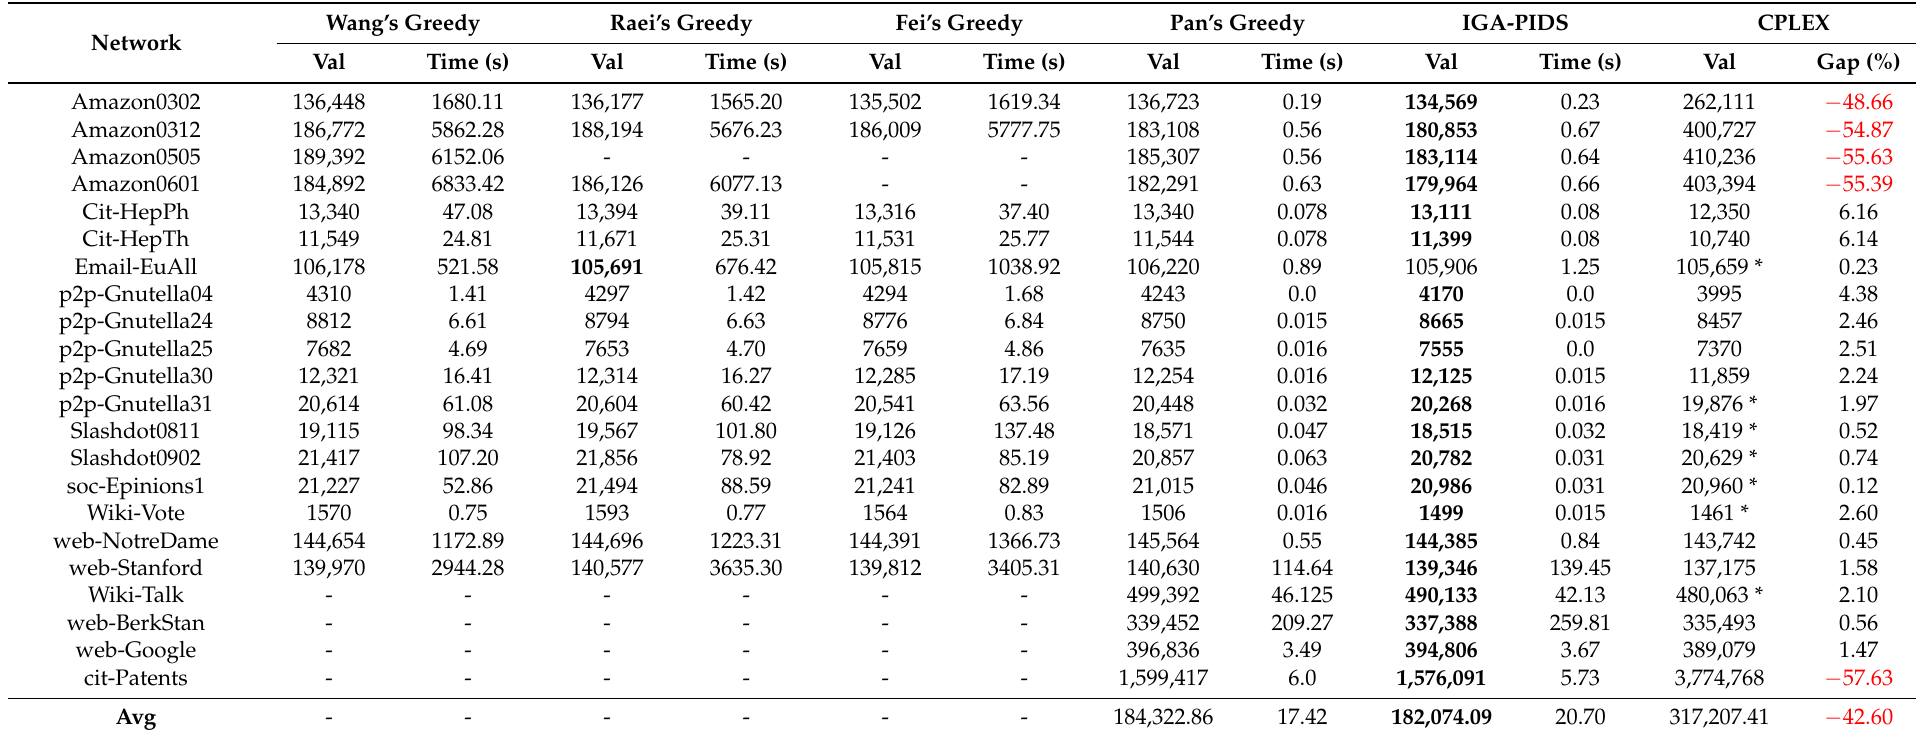
Table 7. Numerical results for the SNAP networks. Red color indicates those cases in which CPLEX fails to find good